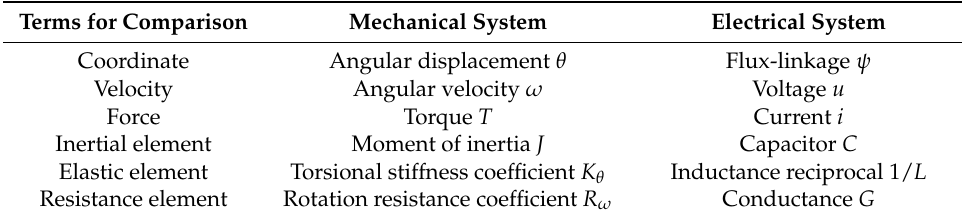
Table 3. The T-i analogy